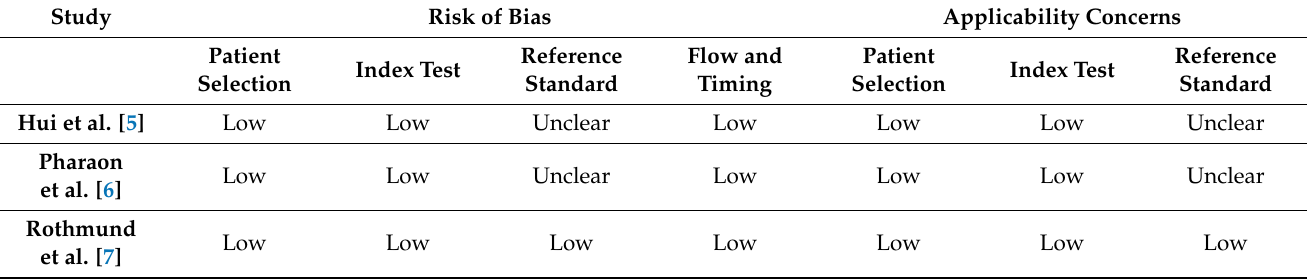
Table 1. QUADAS-2 Risk of Bias Assessment.